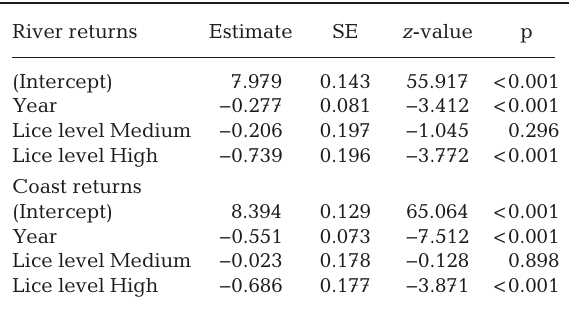
Table 2. Results from selected models (Model 7, see Table 1) of annual returns of 1 sea-winter (1SW) Erriff River Atlantic salmon returning to the river ( S iRiver ) and to the Irish coast ( S iCoast )